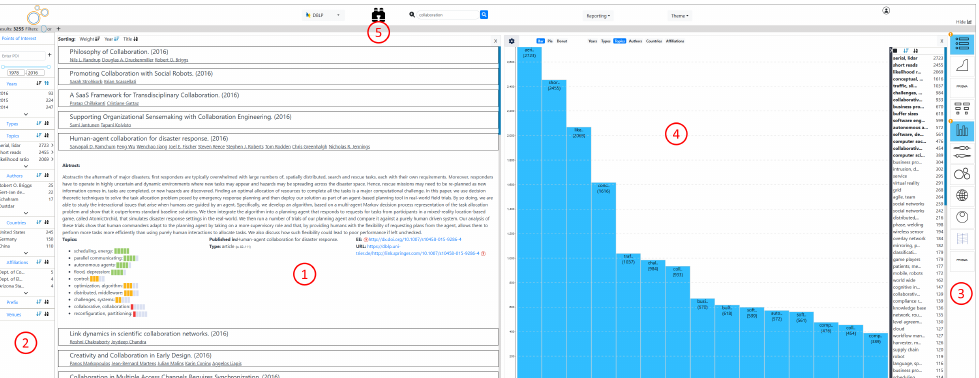
Figure 4. The alternative visual analytics view is based on our previous works [8,28]. (1) lists the result and can be opened with a click to reveal more information about the publication. (2) shows the filters which can be used on the results. (3) shows other visualizations that can be used to visualize the data. (4) visualizes the data in a bar chart showing the number of publications a topic has. (5) is the icon with which users can be taken back to the prototype in Figure